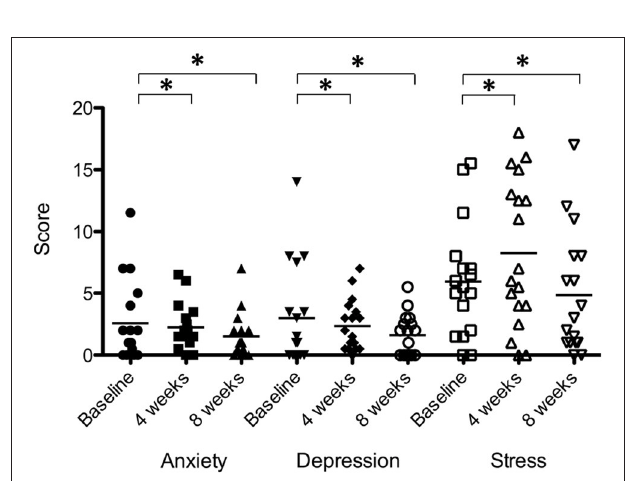
FIGURE 10 | Anxiety, depression, and stress scores of participants at baseline (filled circles for anxiety; inverted triangles for depression; open squares for stress), at 4 weeks follow-up (squares for anxiety; diamonds for depression; open triangles for stress) and at 8 weeks follow-up (triangles for anxiety; unfilled circles for depression; open inverted triangles for stress). Horizontal lines represent average scores. Significant differences are indicated by * p <